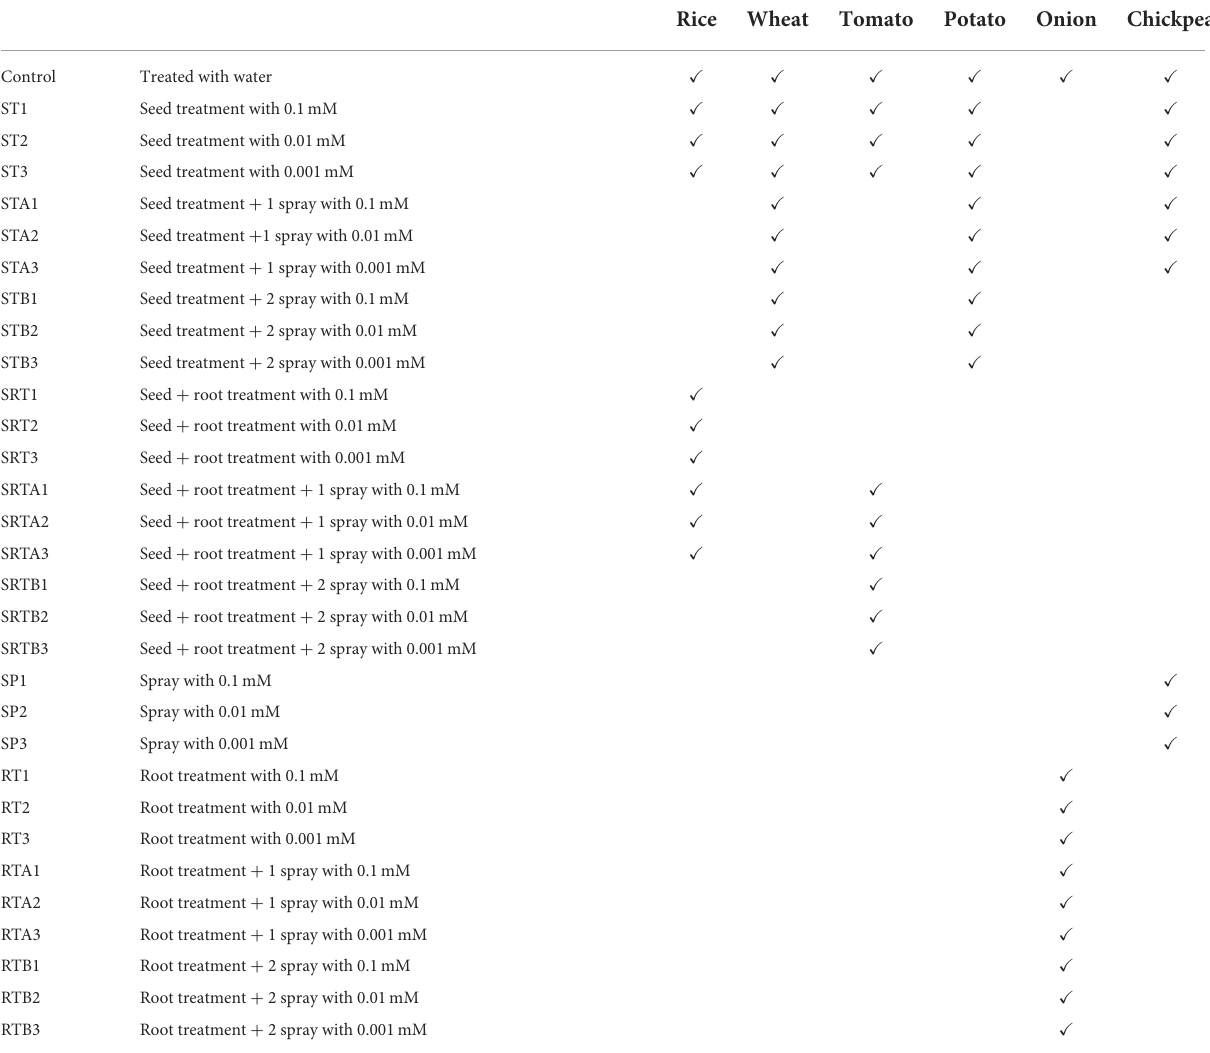
TABLE 1 Detail of treatments used in various crops. Treatments Calliterpenone concentration and application method Crops